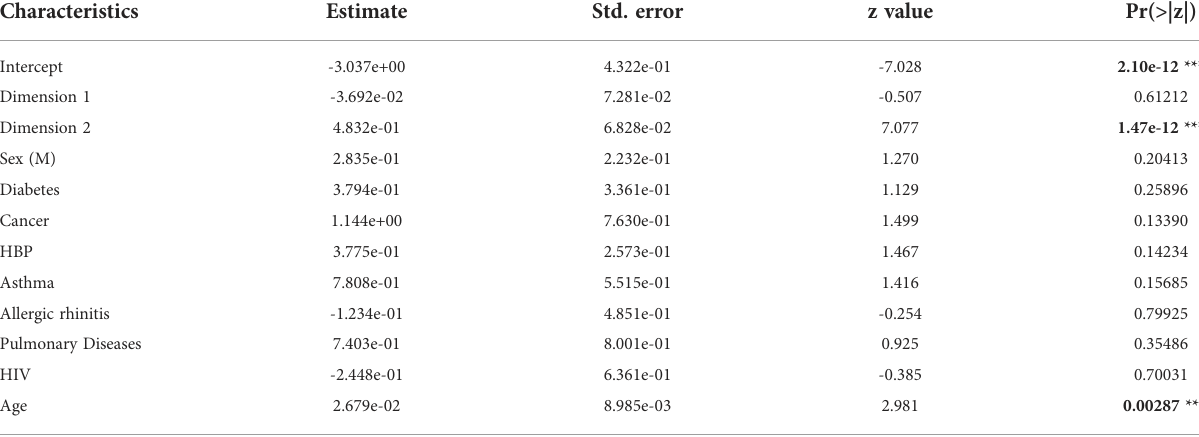
(Table 3). The result of our modelling analysis retained two parameters: increased age (standard error = 8.985e-03, z value = 2.981, p = 0.00287) and biochemical markers associated with TABLE 3 Results of the fi nal multivariable regression model of risk factors associated with COVID-19 severity among Gabonese patients (N=753). Characteristics